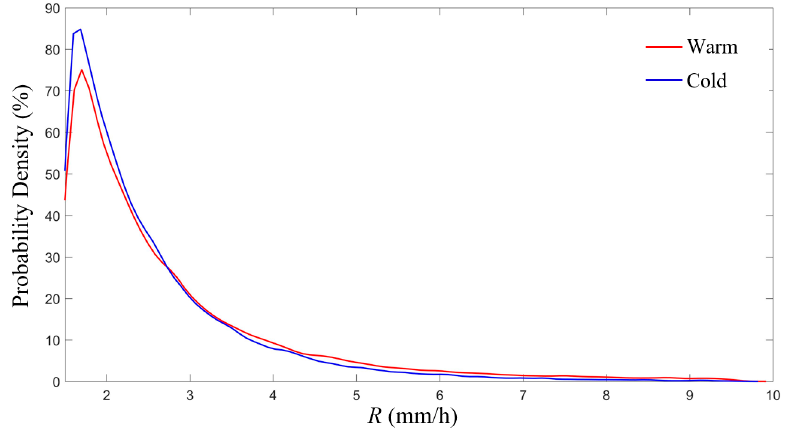
Figure 12. Probability density (%) of rainfall intensity ( 1.5 ≤ 𝑅 ≤ 9.5 , mm/h) for warm and cold seasons, measured from 241 data points.